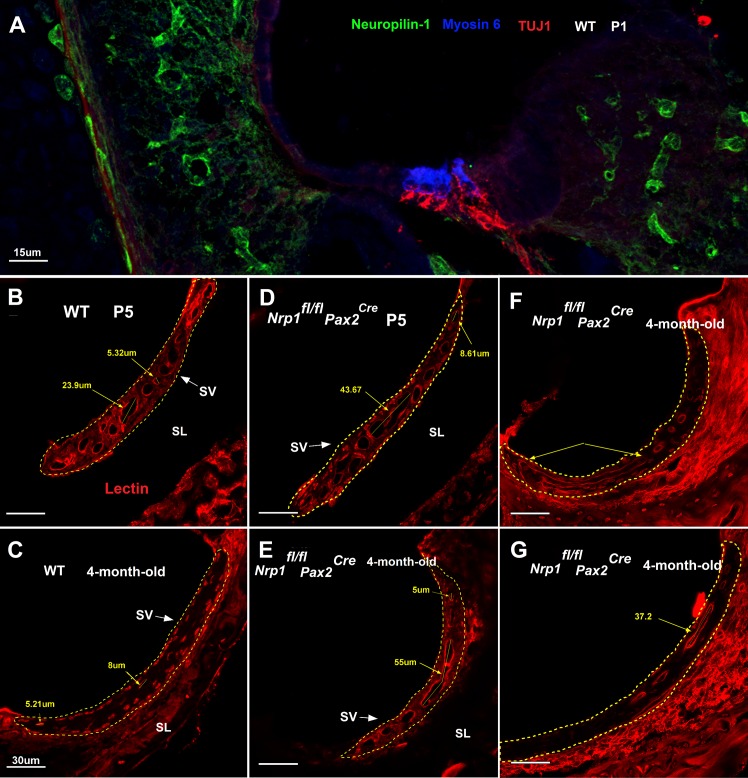
Stria vascularis abnormalities in Nrp1fl/fl;Pax2Cre mutant mice at P5 and 4 months of age.Panel A showing neuropilin-1 expression (green) on vascular tissue of the cochlea. Arrows show neuropilin-1 stained vessels (A). Lectin immunostaining of WT and Nrp1fl/fl;Pax2Cre cochleae at P5 and 4 months of age were performed to assess the morphology of the micro-vessels of the SV at the basal turn of the cochlea (n = 3 per group) (B-G). Grossly enlarged SV microvessels were apparent in both ages of Nrp1fl/fl;Pax2Cre mutants. The minimum and maximum microvessel diameter of the Nrp1fl/fl;Pax2Cre mice were 4.17μm and 43.67μm at P5, and 3.22 and 95μm in 4-month-old mice, respectively. The minimum and maximum microvessel diameters of the WT mice were 5.32μm and 23.90μm at P5, and 5.2μm and 26.15μm in 4-month-old mice, respectively. Panel B and C showing normal morphology of the microvessels of the WT mice at P5 and 4-month-old (B). Nrp1fl/fl;Pax2Cre mutants at P5 showed some enlarged microvessels when compared to WT controls (D). Panel E-G showing vascular abnormalities of 3 different 4-month-old Nrp1fl/fl;Pax2Cre mutants (E, G). Overall, the maximum microvessel diameter in 4-month-old Nrp1fl/fl;Pax2Cre mice was 3.6 fold higher than WT controls. Scale bar = 30 μm.